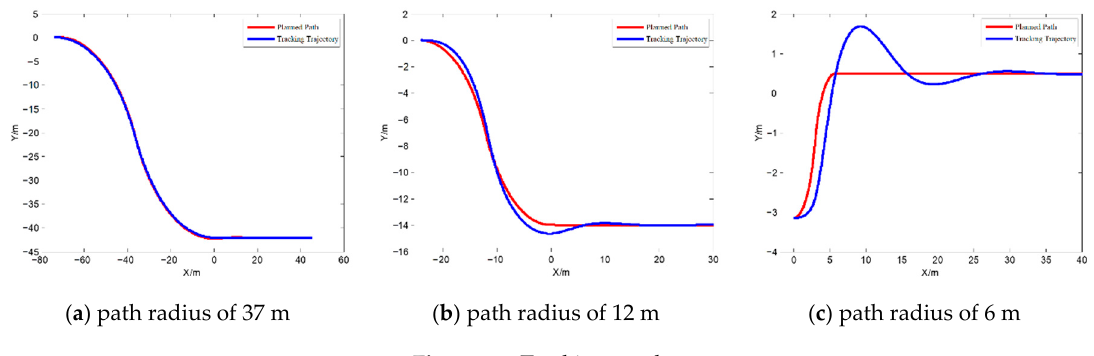
Figure 13. Tracking results.